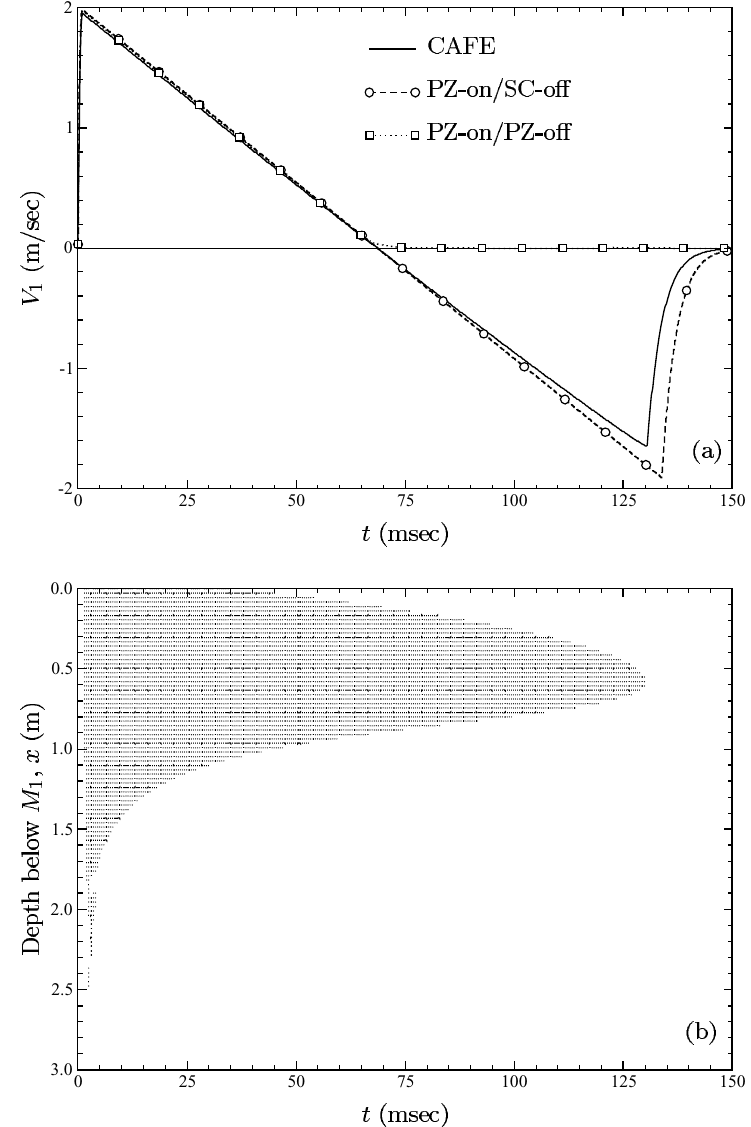
Fig. 4. (a) V 1 -response histories for M 2 /M 1 = 0 , demonstrating the performance of two WSAs (PZ – Pressure Zero, SC – Separation Closure). (b) Cavitation